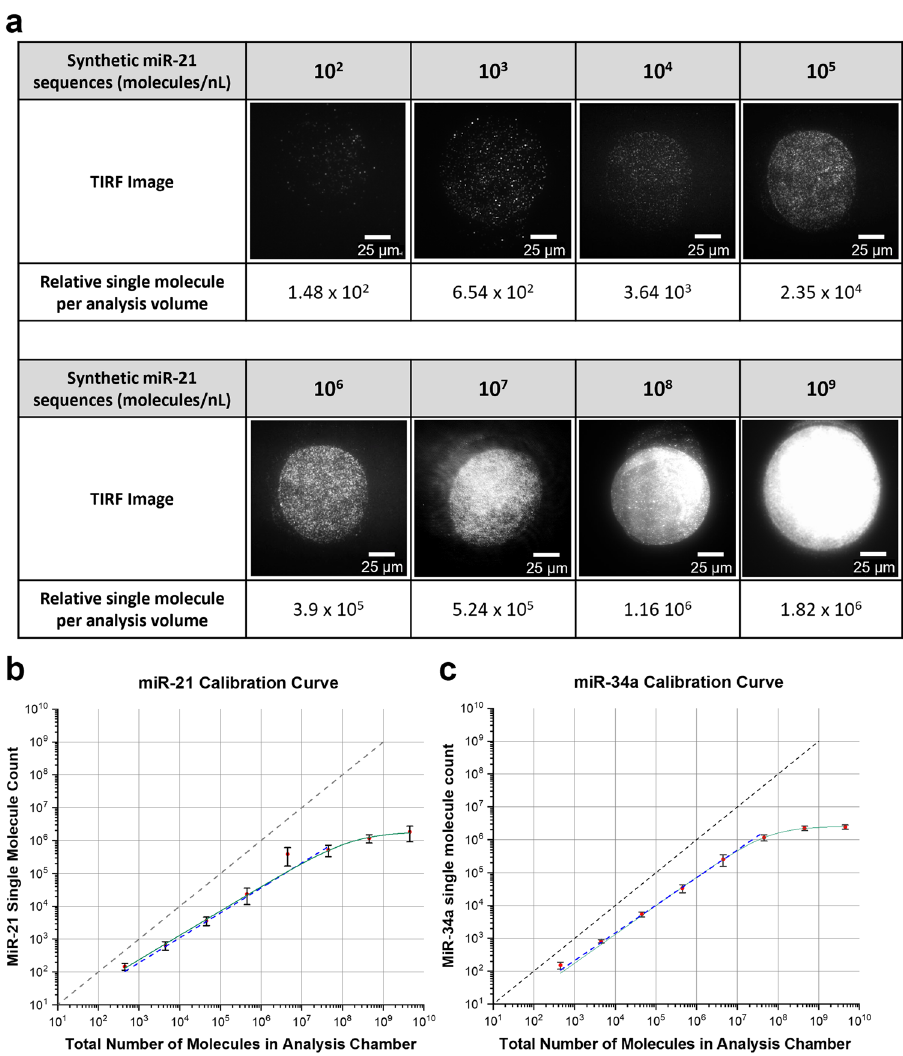
Fig. 2 MiR-21 and miR-34a assay calibration using micro fl uidic chip with 4.5 nL chambers. a Raw TIRF images of 21-capture microarrayed spots within an analysis chamber containing different concentration of synthetic miR-21. Calibration curves were fi tted using a non-linear Hill function shown in green and a power function was plotted in a dashed blue line. Black line represents 100% capture ef fi ciency. Calibration for b miR-21 assay and c and miRNA-34a assay. Data are presented as mean ±